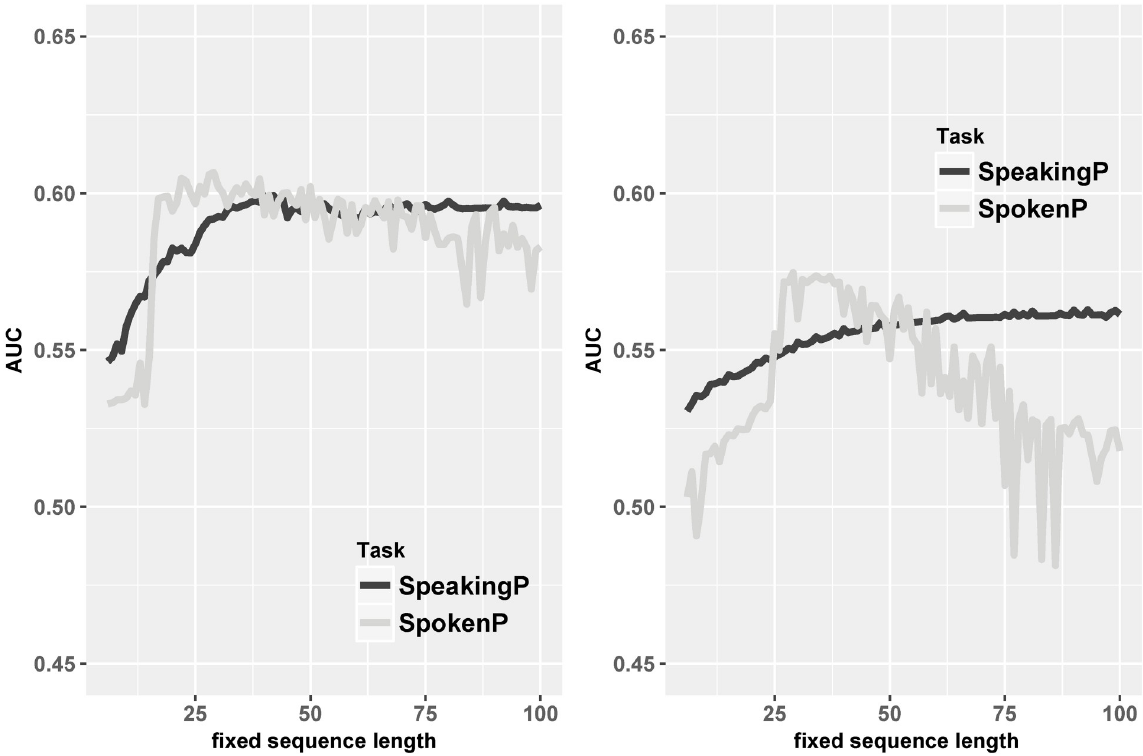
Fig 3. Line plot of the AUC performance of our predictors (SpeakingP and SpokenP) when posts are restricted to having length information only, for different token sequence lengths, for the full dataset (left) and committer-only dataset (right).